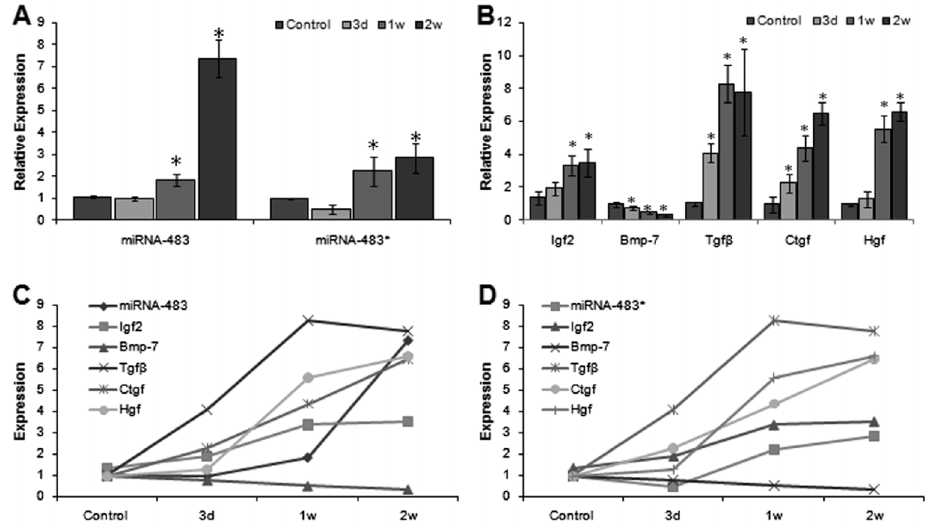
Figure 2. Expression of and relationships among miR-483, miR-483*, and the mRNAs for Bmp7 , Igf2 , Tgf b , Hgf and Ctgf . Real-time PCR was performed on the samples to evaluate the expression of miR-483, miR-483*, and several cytokine mRNAs, including Bmp7 , Igf2 , Tgf b , Hgf and Ctgf . d: days, w: week. *P , 0.05, compared to the control (Dunnett’s multiple comparison test).